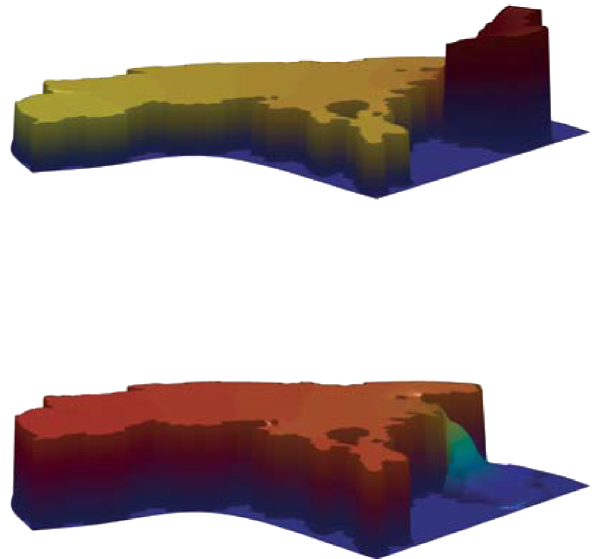
Figure 6. The shape of the lake surface corresponding to the max- imum slope due to the slowest open-channel Helmholtz mode (see also animated surface oscillations in Supplement